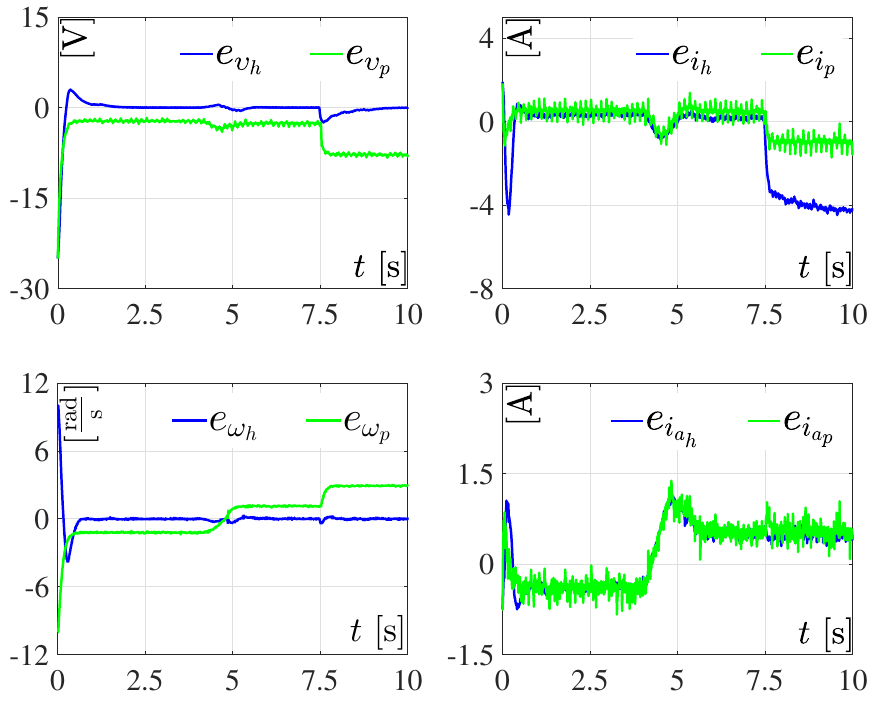
Figure 7. Graphics related to tracking errors, when the abrupt variation in R (Equation (46)) is considered. In these results, the tracking errors associated with the hierarchical controller are denoted by e υ , e i , e ω , and e i , while for the passive controller the corresponding errors are represented by e υ h h ah h e i , e ω , and e i p p ap